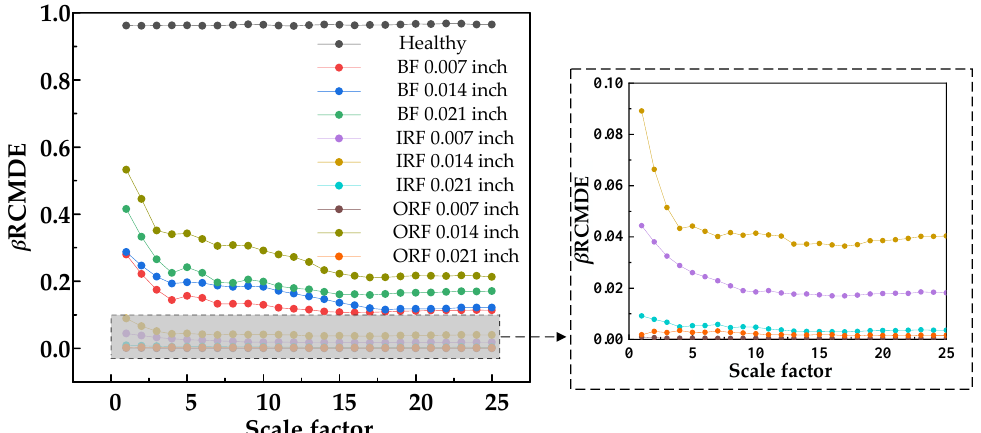
Figure 12. β RCMDE entropy values of 25 scale factors under different damage degrees.